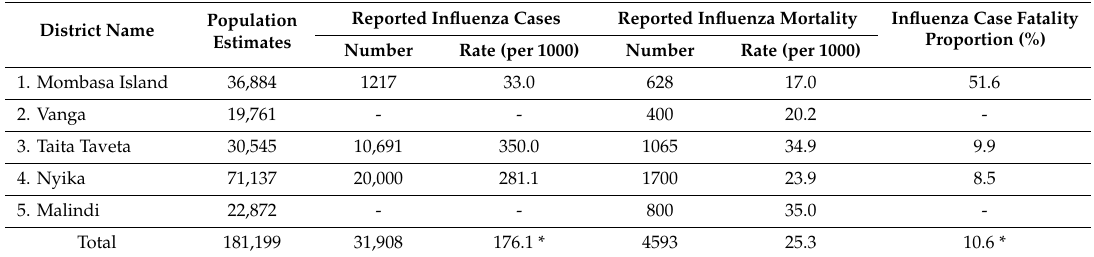
Table 2. Morbidity and mortality burden associated with 1918 influenza pandemic in Coastal Kenya Region, September 1918–March 1919.